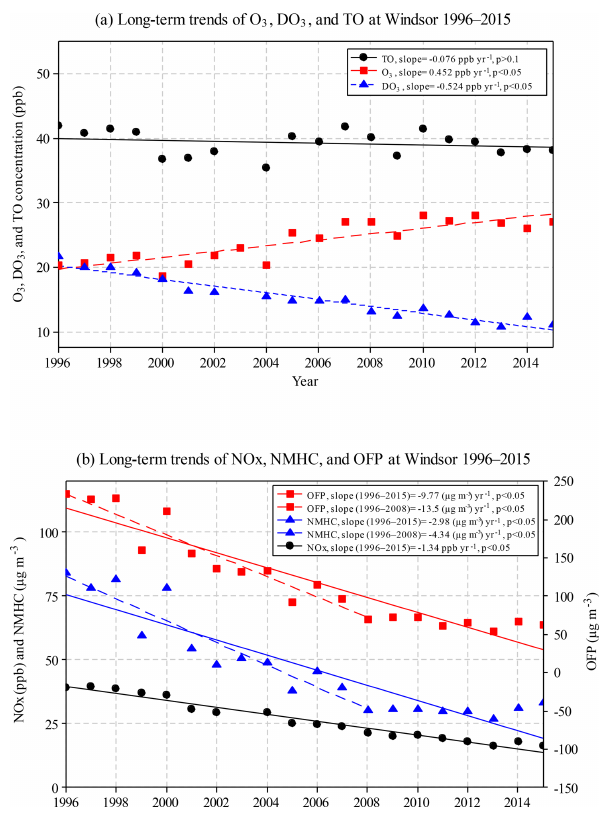
Figure 4. Annual mean concentrations for (a) O 3 , DO 3 , and TO, and (b) NO x , NMHC, and ozone formation potential (OFP) in Windsor during 1996–2015.